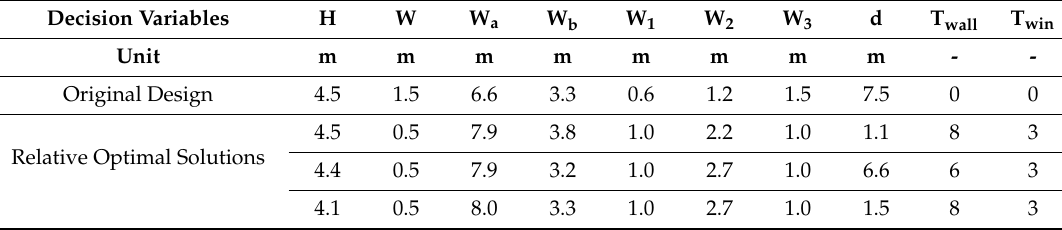
Table 6. Decision variables of the original design and the relative optimal solutions.